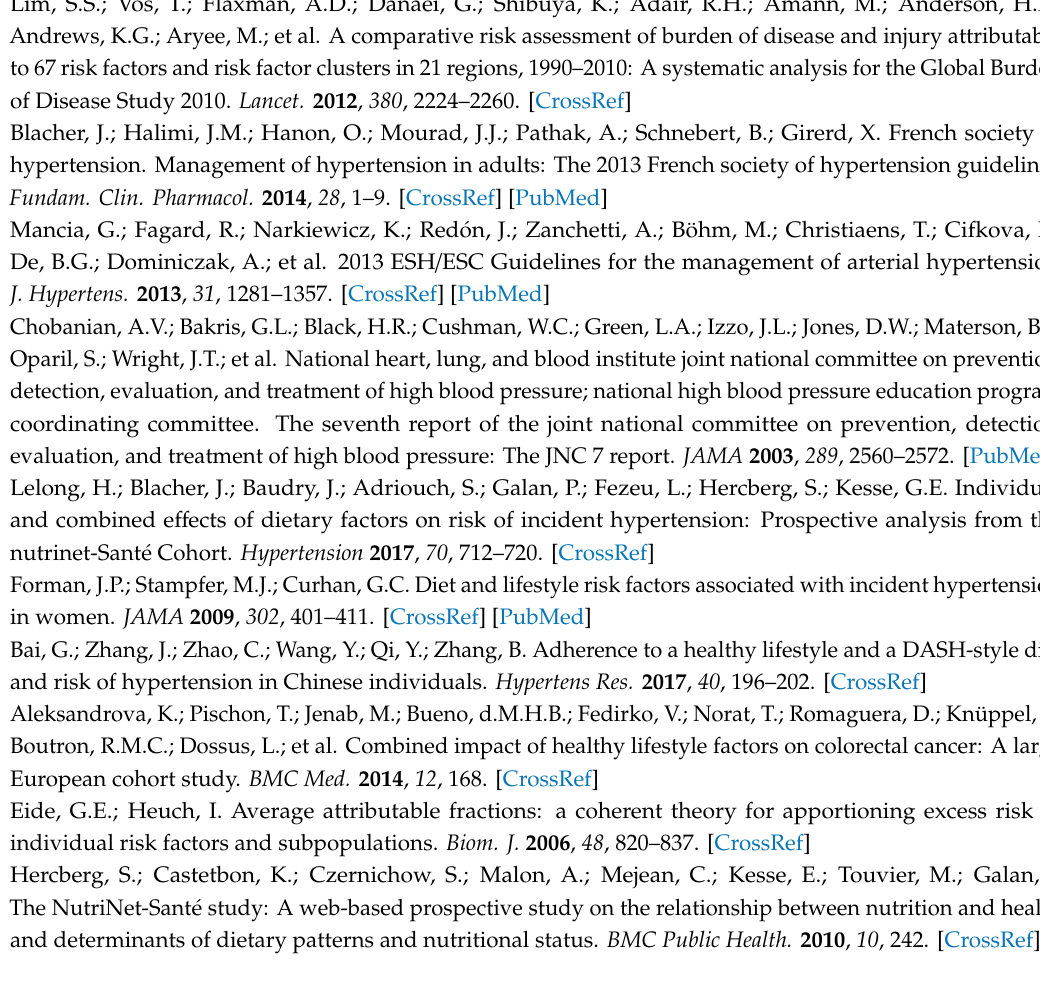
Figure S1: Flow chart, Table S1: Hazard ratios of incident hypertension in relation to Healthy Lifestyle Index